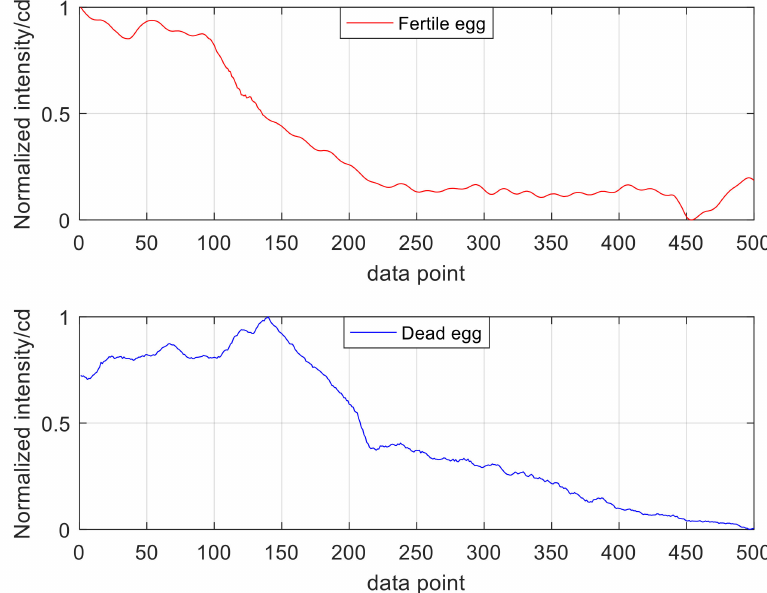
Figure 2. The original waveform of collected heartbeat signal of hatching eggs. The amplitude of heartbeat signal data is normalized to within 0–1 in order to reflect the changes of waveform more intuitively.